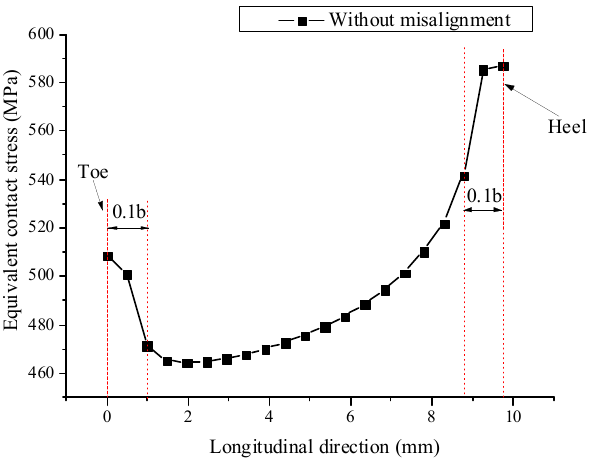
Figure 7. The distribution of contact stress along the direction of tooth width.